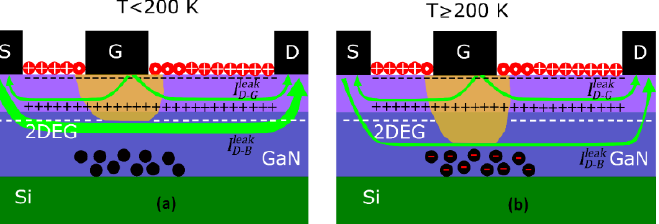
Figure 5. Scheme of fixed charges and electron fluxes in the subthreshold regime at ( a ) low and ( b ) high T. The case shown corresponds to V DS > 0. In cases where V DS < 0, the flow of electrons through the buffer would change direction, whereas those injected by the gate remain unaltered.